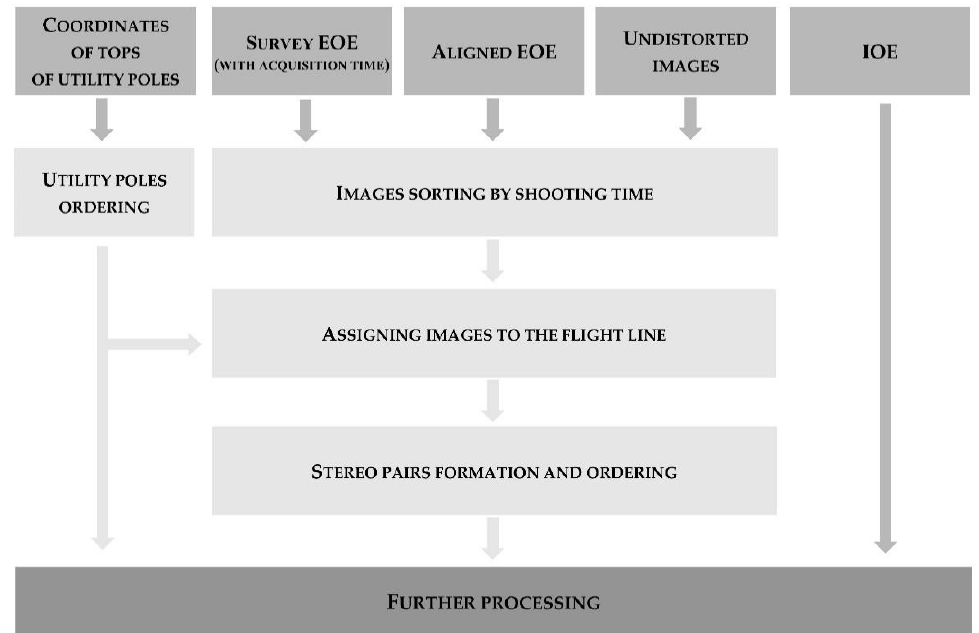
Figure 4. The chart of the first step of algorithm processing. This step of the algorithm is aimed at data ordering for further processing. The survey data (survey exterior orientation elements (EOE)) and the data acquired by means of Agisoft Metashape Professional (aligned EOE, interior orientation elements (IOE), undistorted images, and coordinates of tops of utility poles) are used.